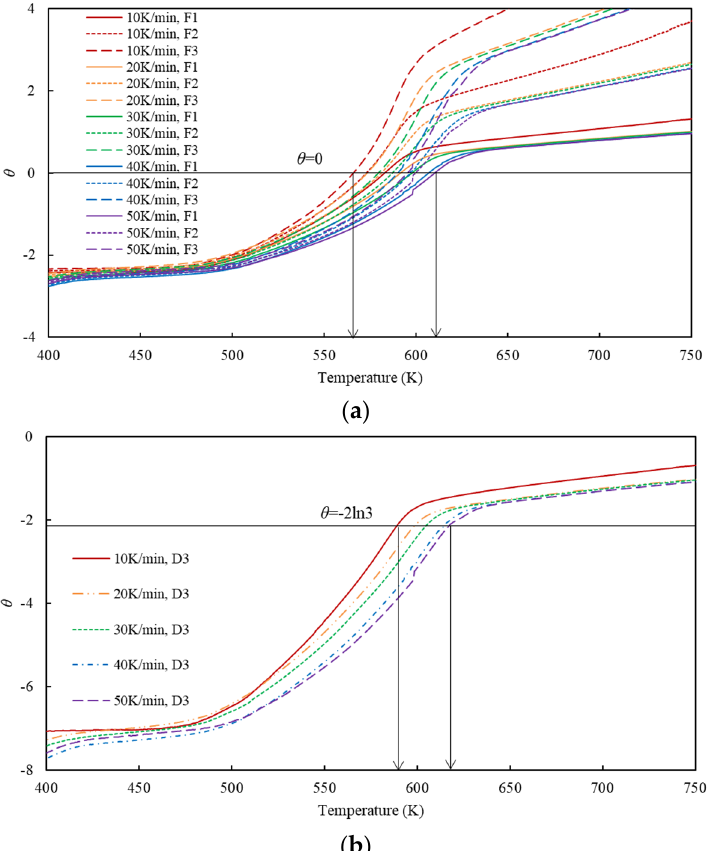
Figure 1. Identification of the conversion rate peak position based on the proposed method for the F1, F2 and F3 reaction model ( a ) and the D3 reaction model ( b ).